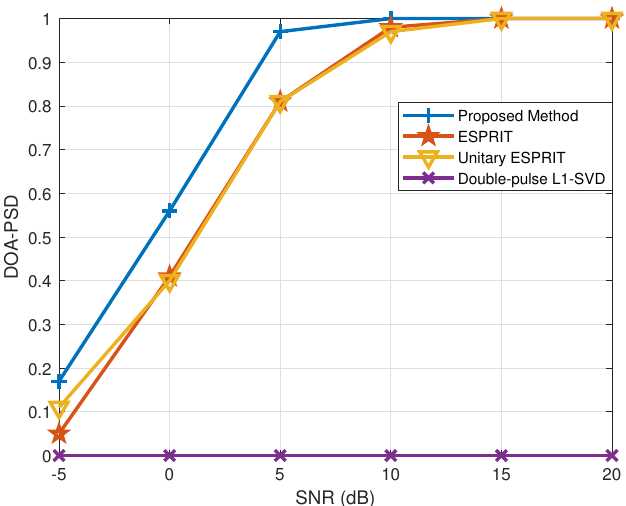
Figure 9. PSD of DOA estimation versus SNR.